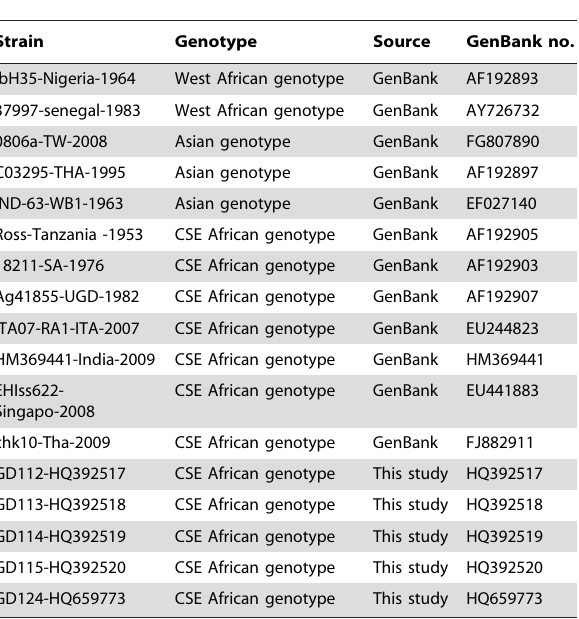
Table 1. E1 gene nucleotide sequences of the CHIKV strains used for phylogenetic